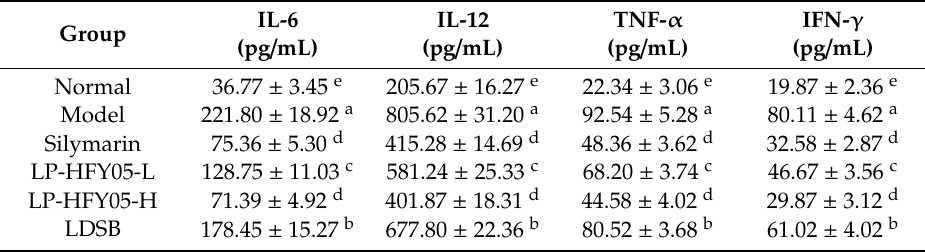
Table 6. Serum levels of IL-6, IL-12, TNF- α , and IFN- γ in mice ( N =